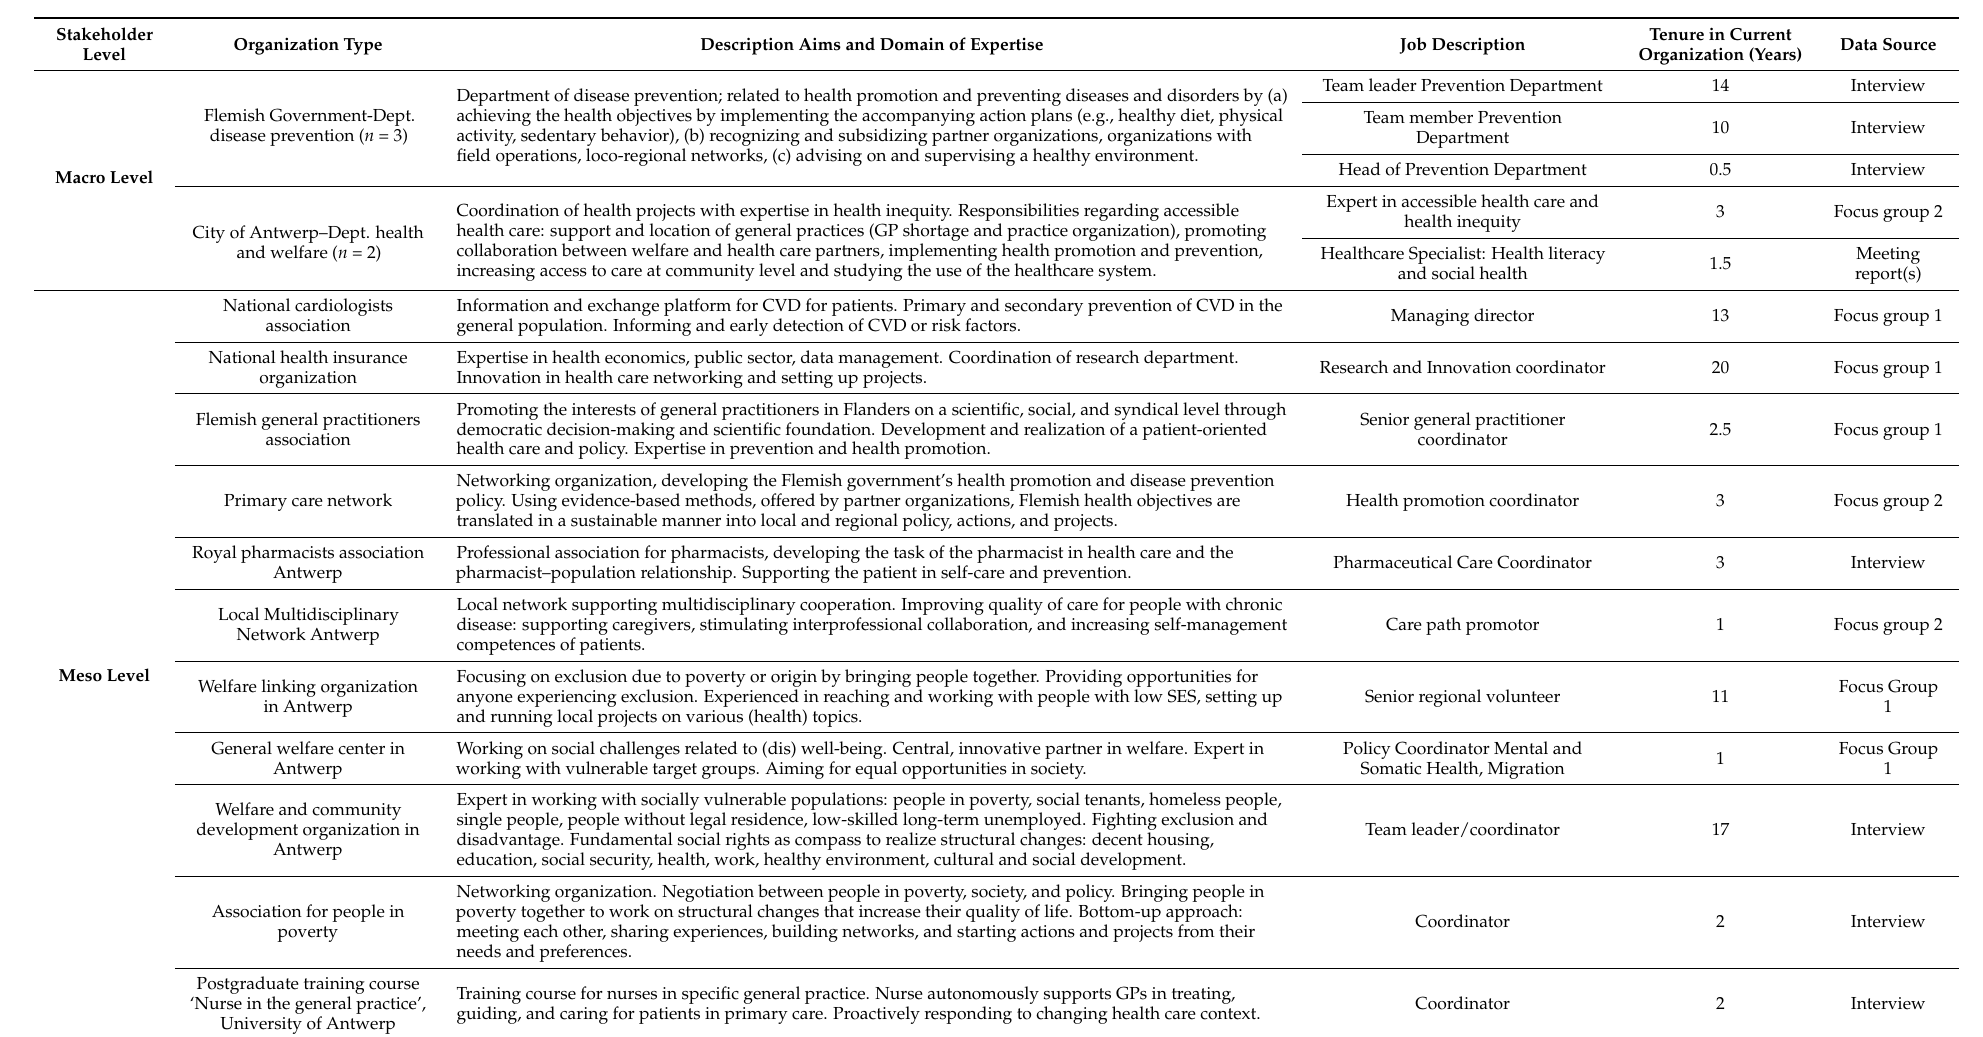
Table 1. Phase 1 macro-, meso-, microlevel stakeholder characteristics ( n =